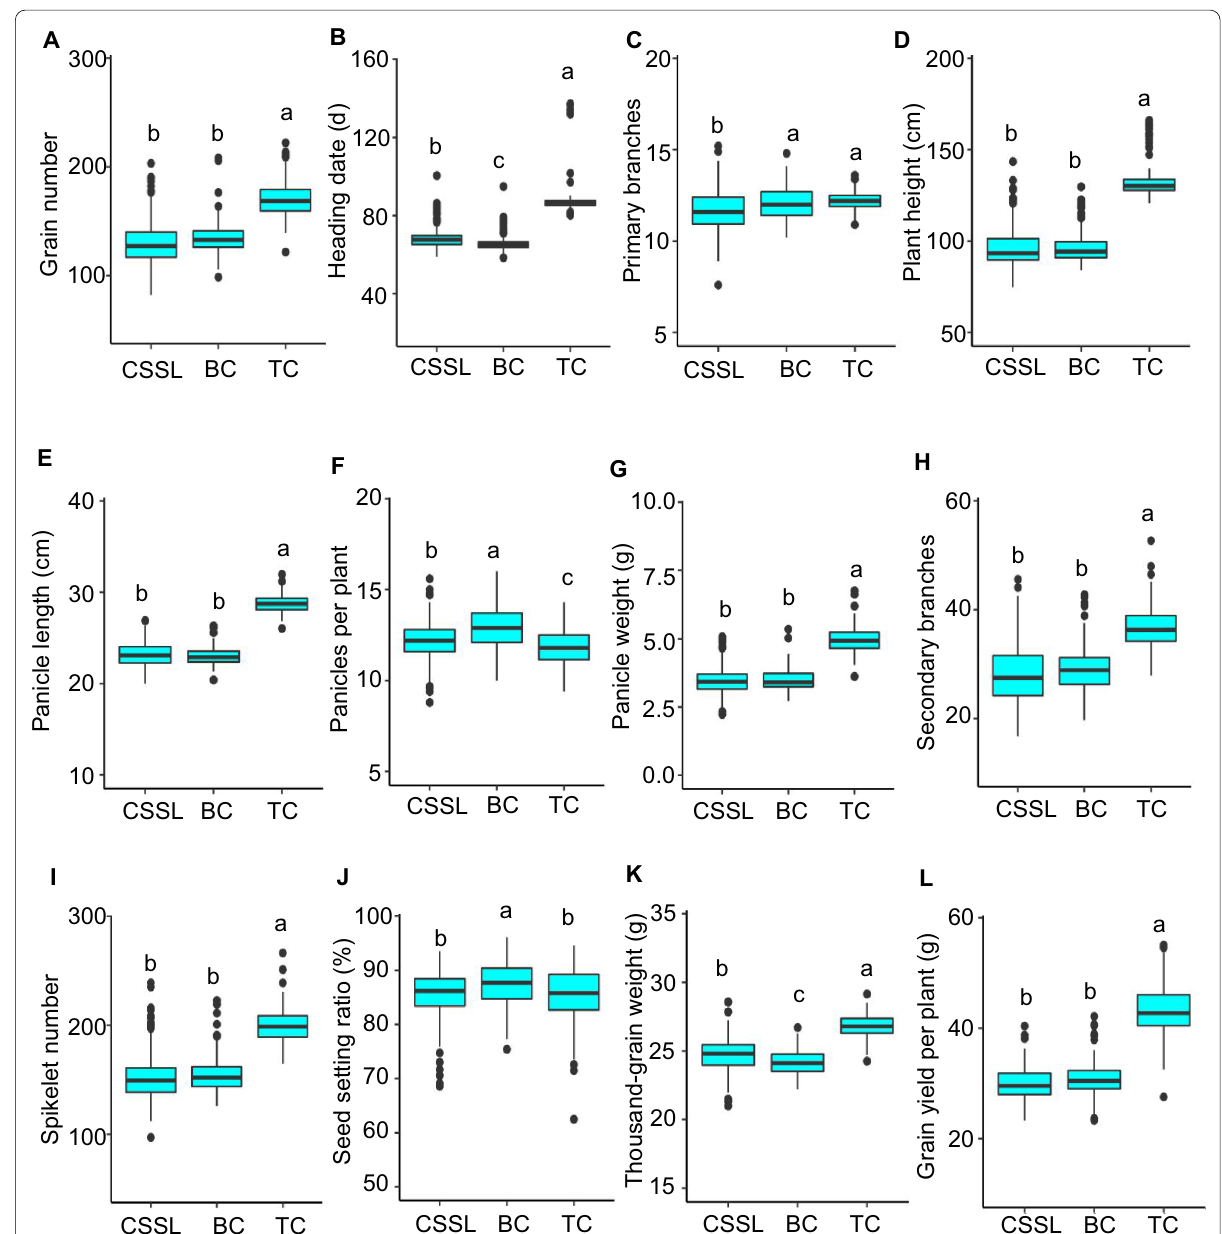
Fig. 1 Boxplots of 12 yield-related traits among chromosome segment substitution lines (CSSLs), backcross population (BC), and testcross population (TC). Box edges indicate the range of the 25th to 75th percentiles, with the median value shown as the bold middle line. The whiskers represent the range of 5% to 95% of the data, and dots are outliers. The different lowercase letters in the boxplots denote significance among the medians of three populations at P <